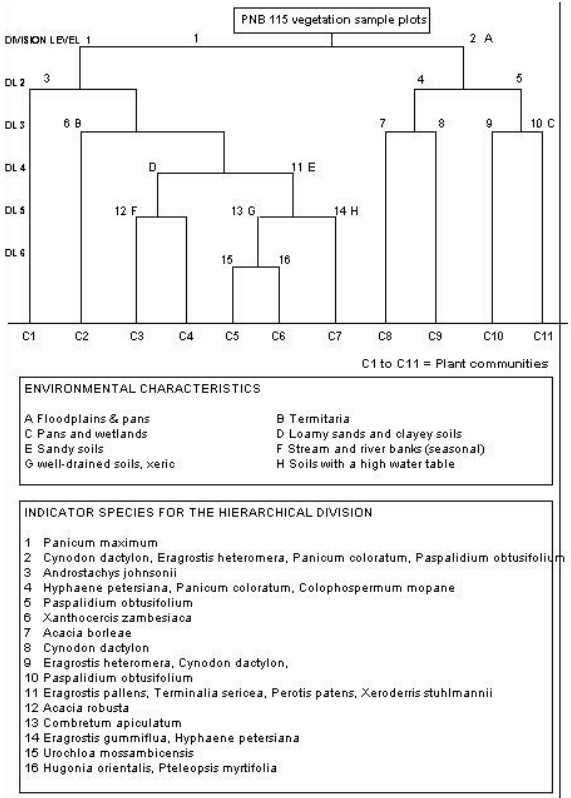
Fig. 6. T WINSPAN dendrogram for 115 vegetation sample plots in the Parque Nacional de